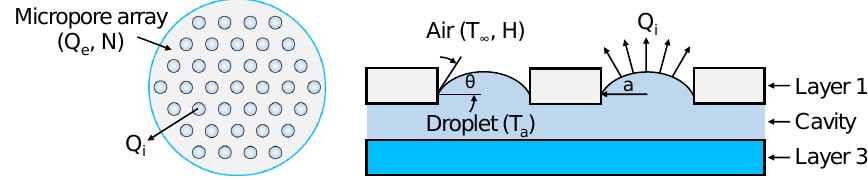
Figure 2. Schematic of sessile droplets evaporated from the arrayed